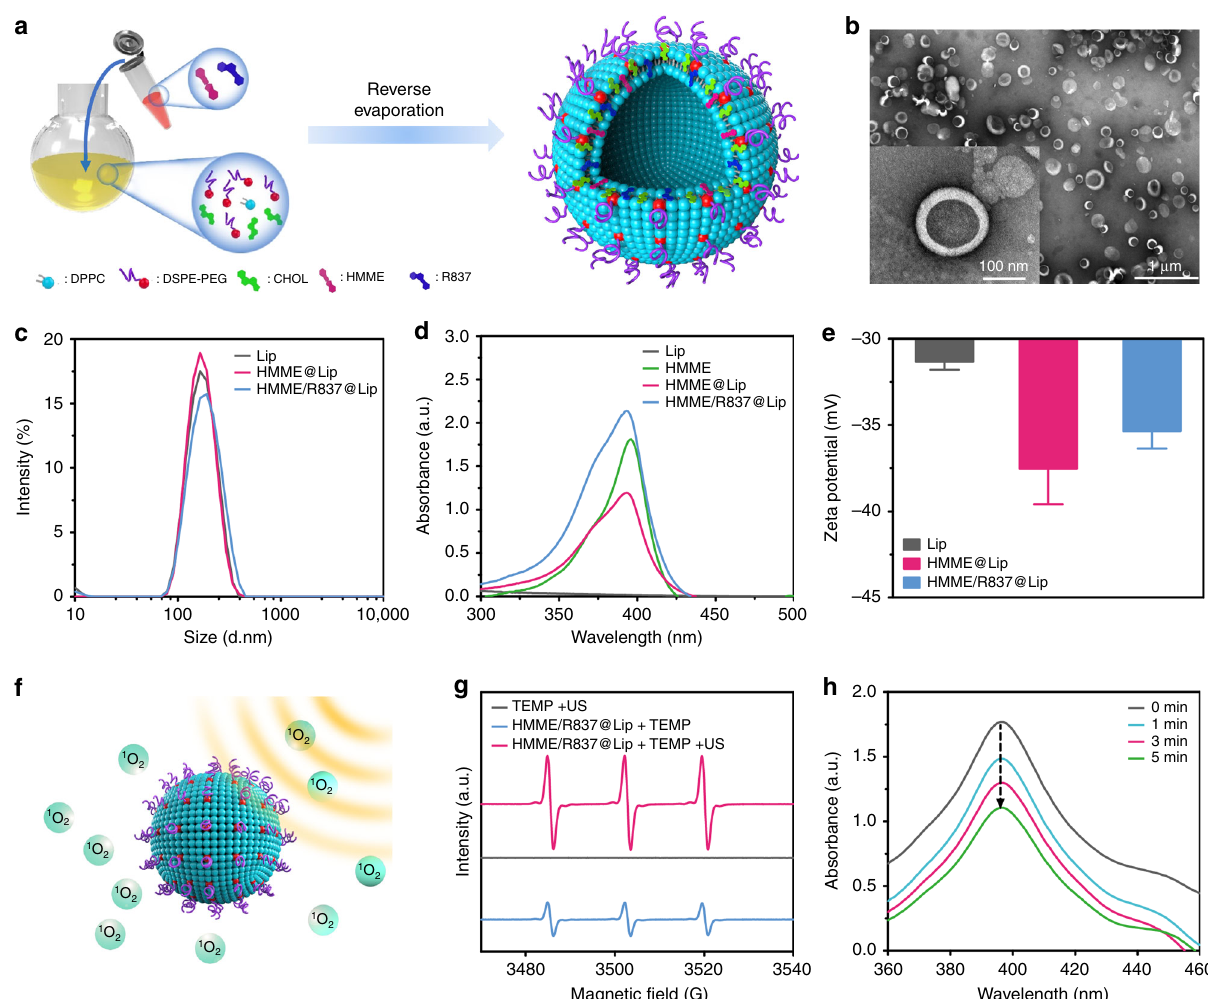
Fig. 2 Synthesis and characterisations of the composite nanosonosensitisers. a Schematic illustration of the construction of HMME/R837@Lip nanosonosensitisers and their microstructures; b TEM image showing the quasi-spherical morphology of HMME/R837@Lip with high dispersity (scale bar = 100 nm); c hydrodynamic diameters of HMME/R837@Lip nanosonosensitisers in PBS as measured by DLS; d UV-vis absorbance spectra of Lip, HMME, HMME@Lip and HMME/R837@Lip, indicating the successful encapsulation of HMME into the nano-liposome; e zeta potential of Lip, HMME@Lip and HMME/R837@Lip, error bars are based on SD ( n = 3); f scheme of US-triggered 1 O 2 production as assisted by HMME/R837@Lip; g ESR spectra of HMME/R837@Lip with or without US treatment; h time-dependent DPBF absorption spectra in the presence of HMME/R837@Lip under US irradiation for varied